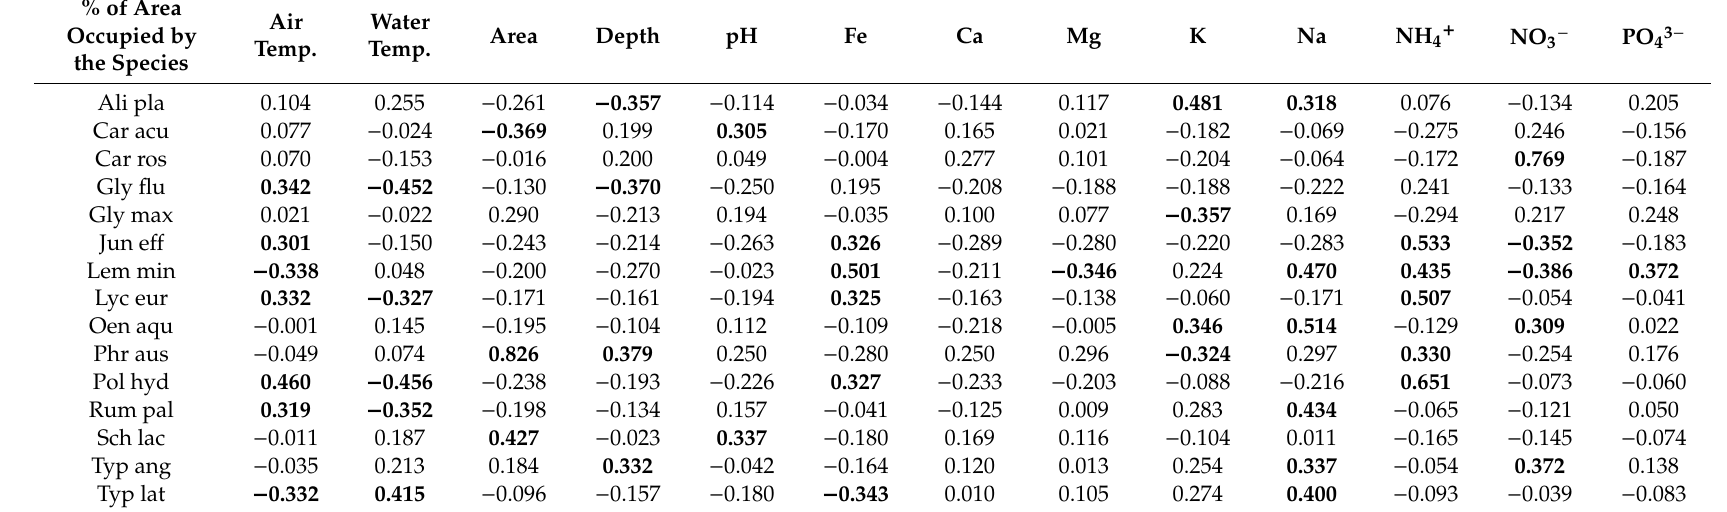
Table 8. Pearson’s correlations between distribution of macrophyte species and the variables